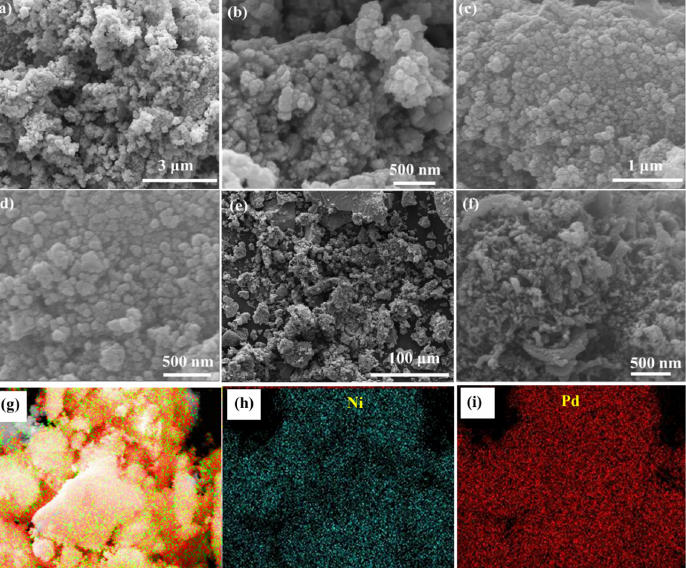
Figure 2. Low and high magnification SEM images for ( a , b ) Ni 0.85 Pd 0.15 , ( c , d ) Ni 0.80 Pd 0.20 , ( e , f ) Ni 0.75 Pd 0.25 , and ( g – i ) EDS elemental mapping of Ni 0.75 Pd 0.25 sample. TEM measurements were used to determine the size and structure of different Ni-Pd alloys. Ni 0.85 Pd 0.15 shows aggregated metallic nanoparticles with an average diameter of 8 nm and a d-spacing of 0.25 nm corresponding to the (111) plane of NiPd nanoalloys, as